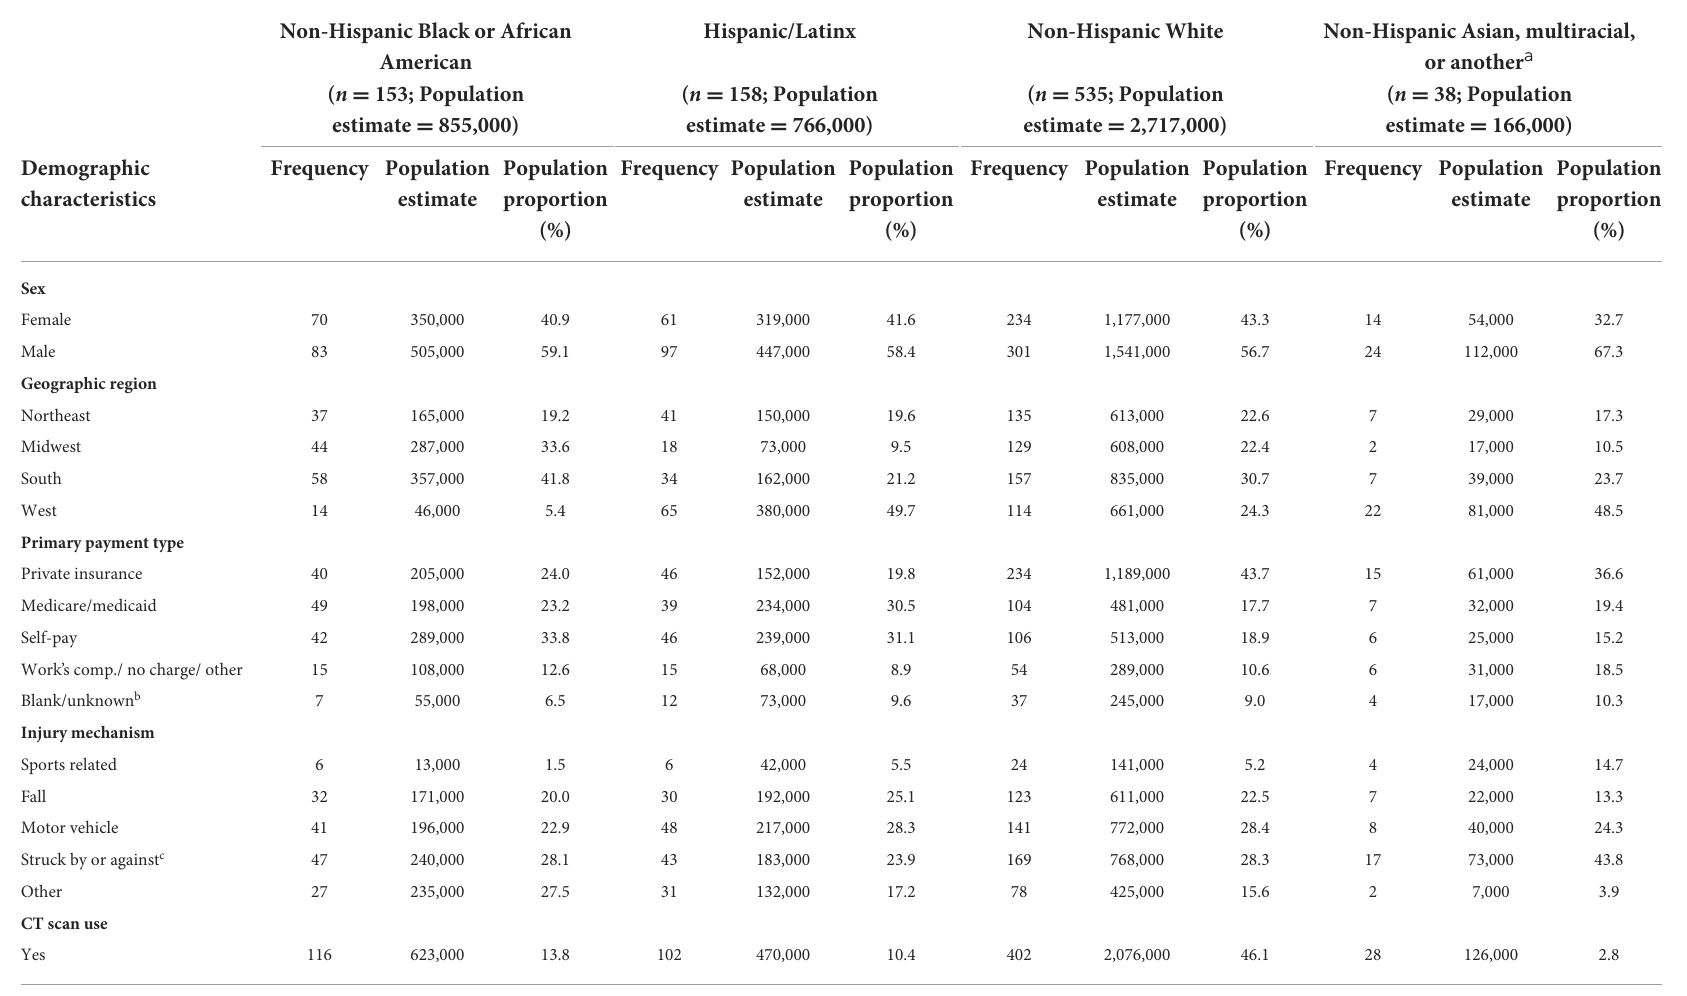
TABLE 2 Adult emergency department visits with concussion across race/ethnicity ( n =